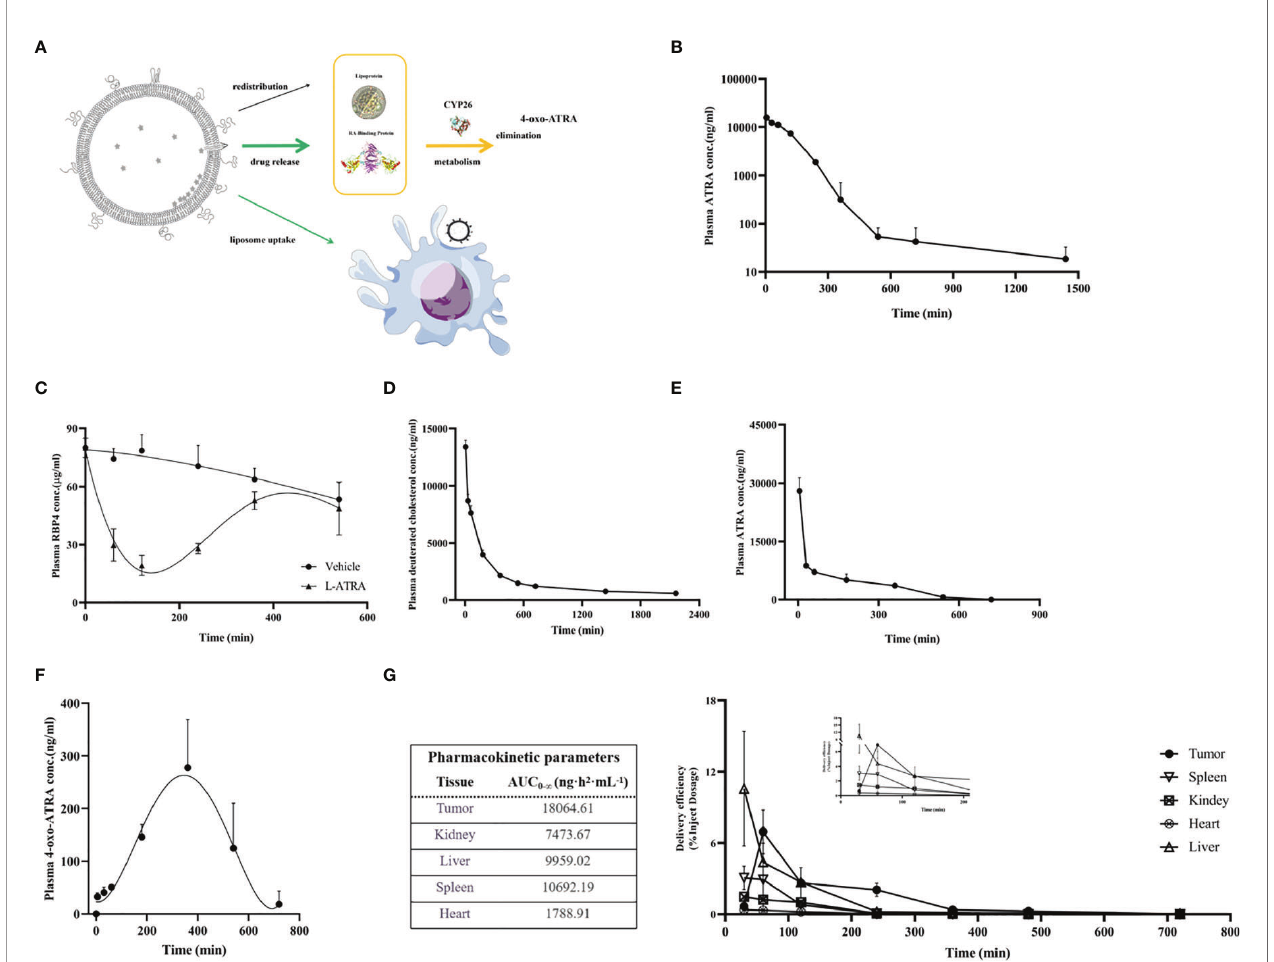
FIGURE 3 | L-ATRA pharmacokinetics and tissue distributions after iv injection. (A) Schematic drawing of pharmacokinetics of L-ATRA in vivo ; (B) Plasma ATRA concentration curves after L-ATRA i.v. injection in mice; (C) The measurements of RBP4 concentration changes after L-ATRA injection in mice; (D – F) . Plasma concentrations of (D) ATRA, (E) deuterated cholesterol, and (F) 4-oxo ATRA after L-ATRA i.v. injection in Beagle dogs; (G) ATRA concentrations in various tissues after L-ATRA i.v. injection in CT26 tumor bearing